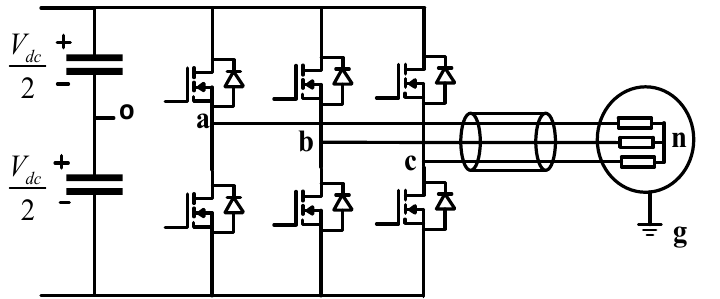
Figure 1. Structure diagram of three ‐ phase voltage source inverter.